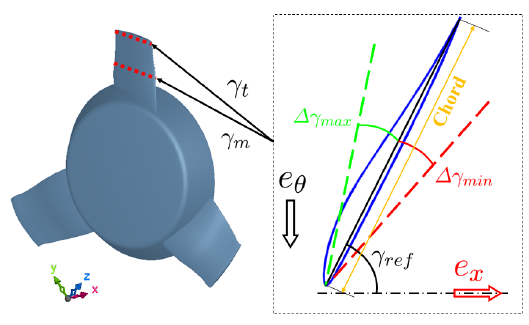
Figure 4. Geometrical parameter